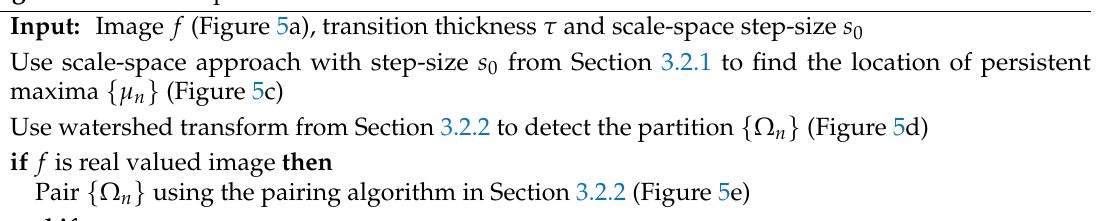
Algorithm 2 The Empirical Watershed Wavelet